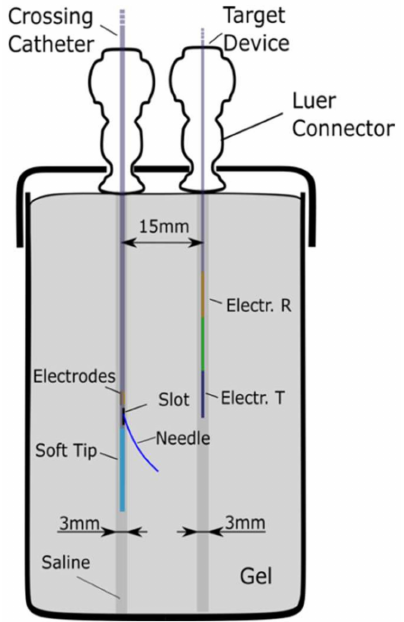
Figure 8. Schematic representation of the saline and gel phantom